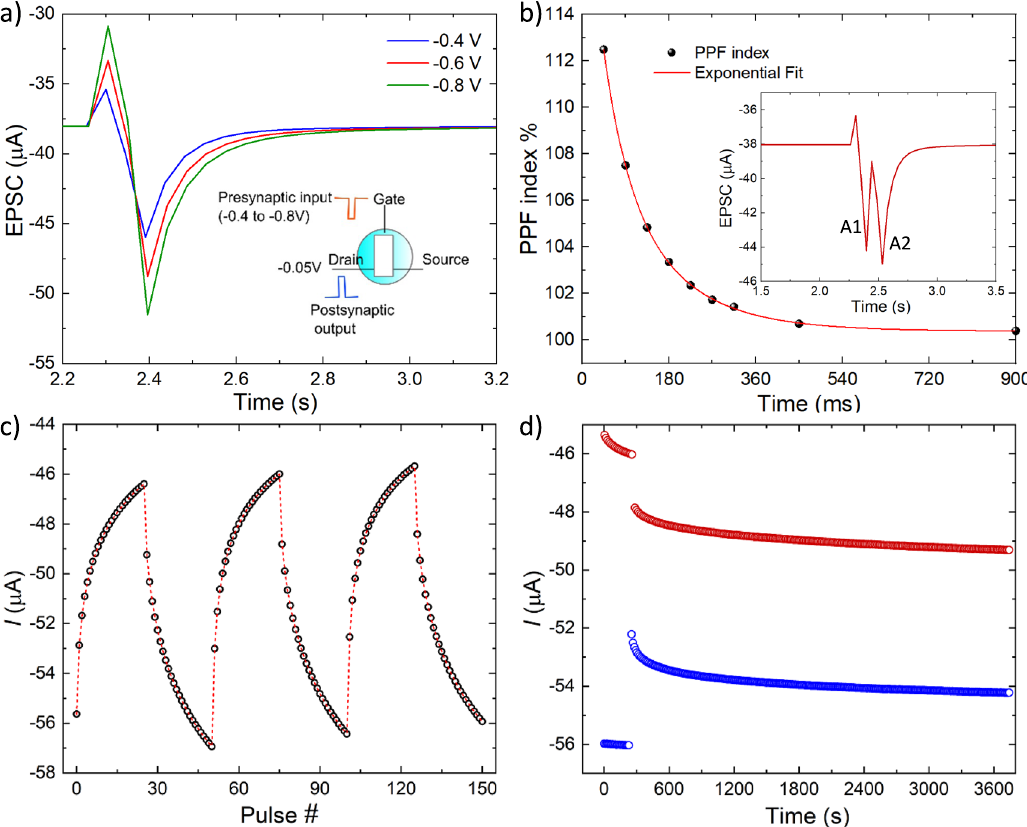
Fig. 6 Long-term memory response. a Excitatory postsynaptic current measured at the drain ( − 0.05 V) on application of various gate pulse voltages of 90 ms duration. b Paired-pulse facilitation indices of the synapse operating in the short-term doping/dedoping mode. PPF index is given by (A 2 /A 1 ) × 100 (see inset). The increase in EPSC on application of consecutive gate pulses separated by Δ t. c Long-term depression and potentiation in the synapse exhibiting 25 distinct levels. Depression is induced by 1.1 V pulses of 2.5 s duration and potentiation by − 0.6 V pulses of 4 s duration. The time delay between two consecutive write pulses is 20 s. The conductance state is read using a drain voltage pulse of − 0.05 V, 10 s after writing. d Retention of two states, A and B, over 1